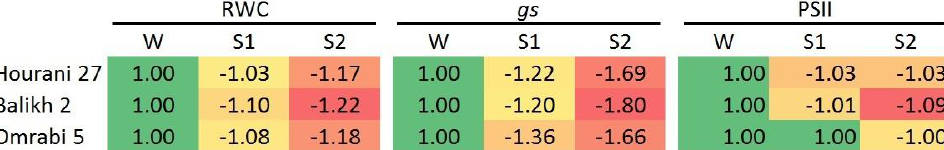
Figure 1. Comparison of RWC ( A ), stomatal conductance ( B ) and PSII activity ( C ) in three durum wheat cultivars (Hourani 27, Balikh 2 and Omrabi 5). Data represent means ± SD. Lower case letters indicate differences between treatments (W, S1 and S2) for each genotype as determined by LSD ( p < 0.05).